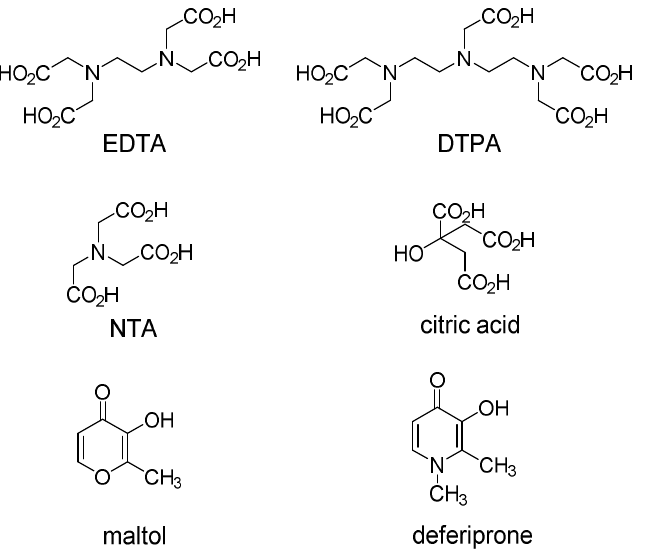
Figure 2. Structures of iron(III) chelators. Table 1. Rate of NPBG hydroxylation by different iron complexes. Rate of Molar Ratio Chelator Chelator: Fe